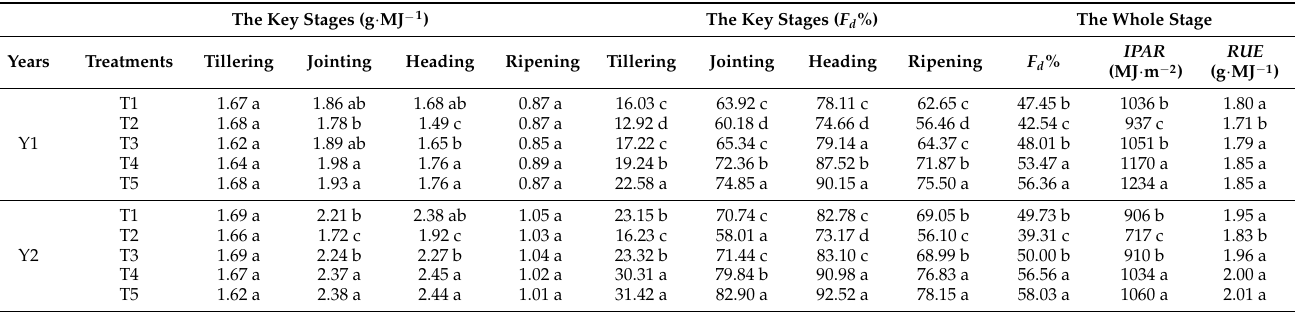
Table 2. The RUE at different stages with different HA treatments.